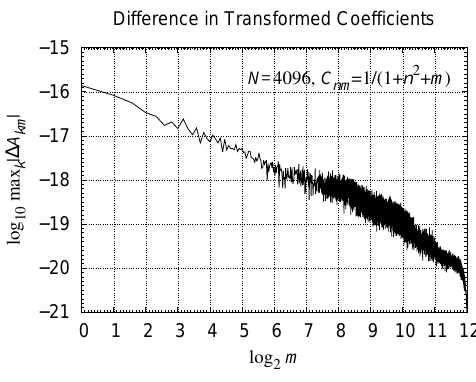
Figure 1: Difference in transformed coefficients between old and new methods. Shown are the absolute differences in A km between the old method (Fukushima, 2018, §2.1) and the new method de- scribed in Sect. 2. The input data are the model spherical harmonic coefficients, C nm ≡ 1/ (cid:0) 1 + n 2 + m (cid:1) , where 0 ≤ m ≤ n ≤ N = 4096 . Plotted is the maximum absolute difference of A km for 0 ≤ k ≤ N as a function of m in a double logarithmic manner.